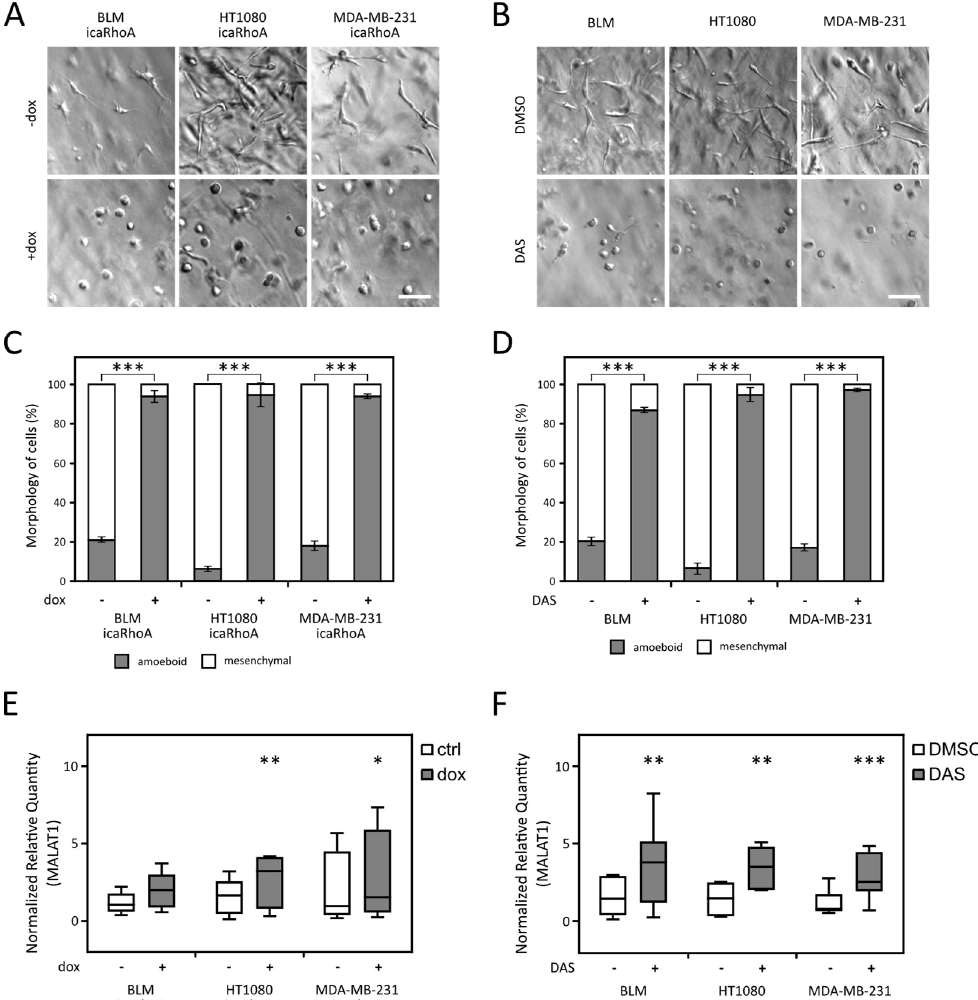
Figure 2. Morphological and RT-qPCR analysis of cell lines undergoing MAT (mesenchymal to amoeboid transition). ( A ), ( B ) Representative wide-field images of cells in 3D collagen matrix with or without induction of MAT. ( C ), ( D ) Quantification of cell morphology in 3D collagen. Data represent the mean ± SD. ( E ), ( F ) RT-qPCR analysis of the MALAT1 (metastasis-associated lung adenocarcinoma transcript 1) gene expression. Median values are marked in the box plots, whiskers represent min to max range. Parts ( A ), ( C ), and ( E ) depict cell lines with inducible constitutively active RhoA used for the MAT induction. ( B ), ( D ), and ( F ) depict cell lines treated with dasatinib (DAS) to induce MAT. p - values: *** p < 0.001, ** p < 0.01, * p < 0.05. Scale bar 75 μ m in all cases. All data are a representation of